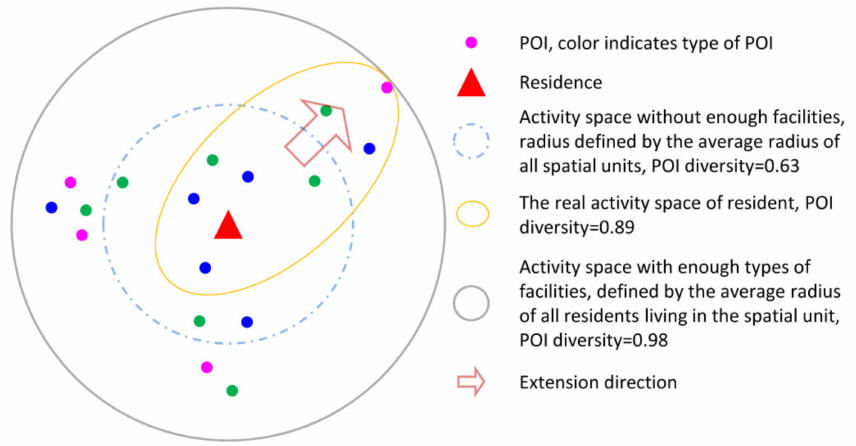
Figure 7. The directional extension of activity space leads to high POI diversity and large activity space.